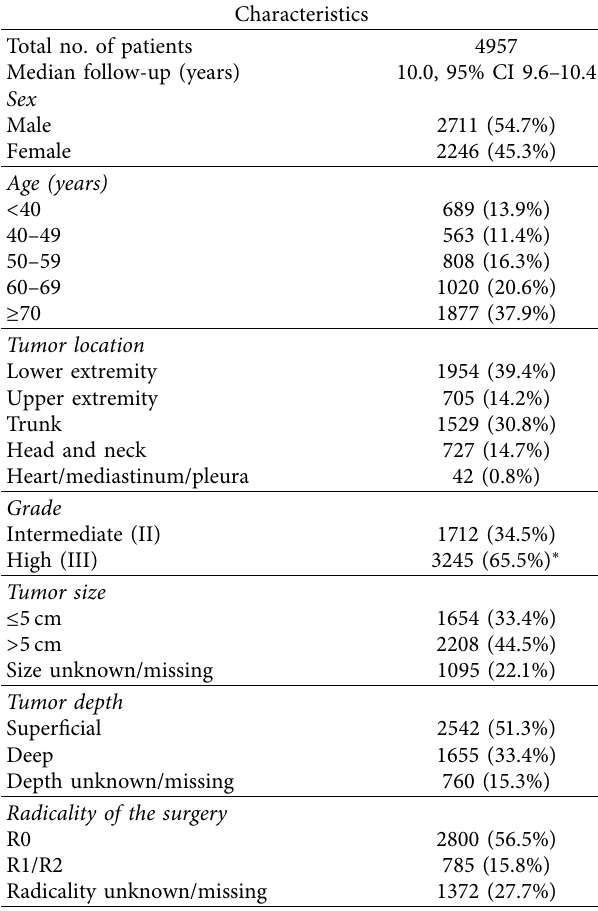
Table 1: Patient characteristics for grade II and III resected soft tissue sarcoma in the Netherlands between 2000 and